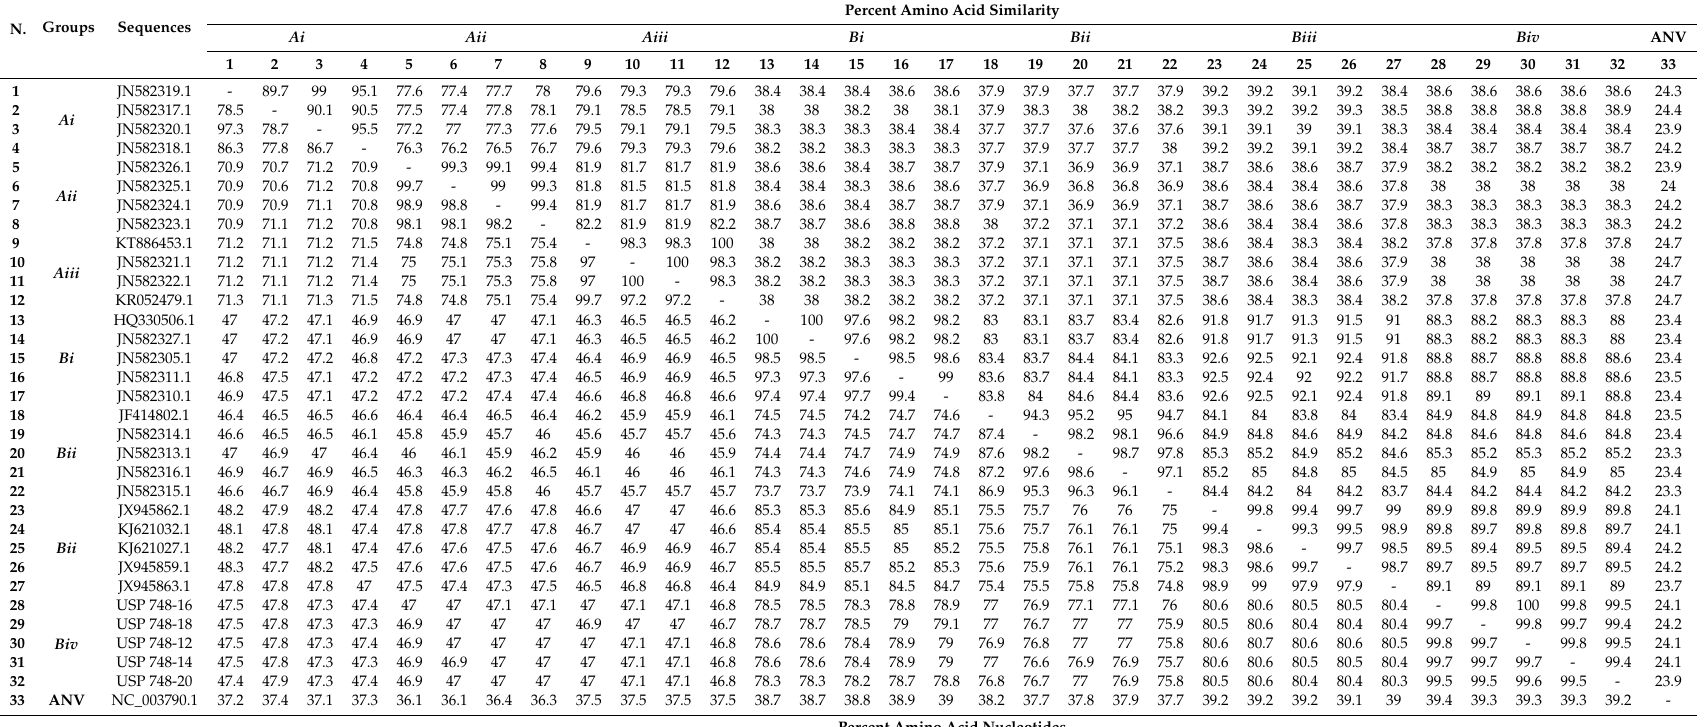
Table 3. Comparison of the nucleotide and amino acid identities of the sequences of Brazilian isolates of CAstV with other sequences of this virus. N. Groups